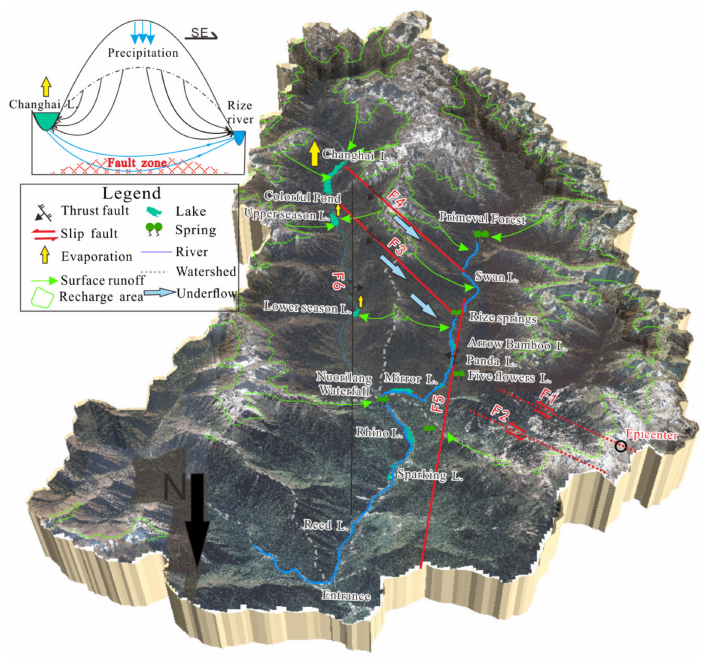
Figure 13. Schematic of conceptual model of three-dimensional post-earthquake water cycle. F1–6 represent faults shown in Figure 2a in